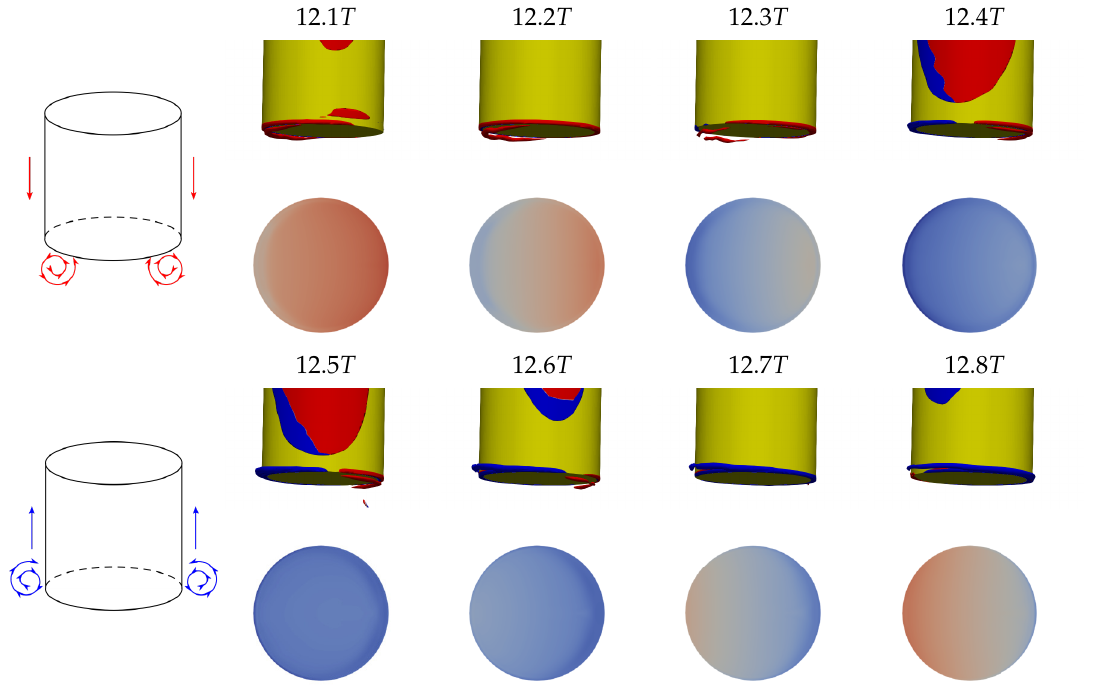
Figure 8. Vortex formation and pressure distribution over a wave cycle in the fixed case. The Q = 200 iso-surface is colored by rotation direction (inward rotation is red and outward is blue, see schematics on the left). Top two rows are upward motion, bottom two rows are downward motion. The colour-scale of the pressure distribution goes from blue to red in [ 0.5, 0.5] (-). The wave propagates from left to − right in all